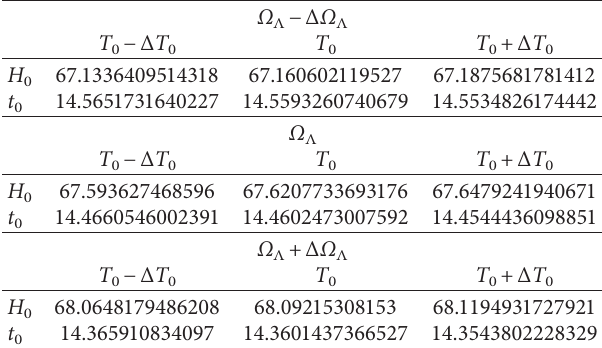
Table 3: H 0 (km/s/Mpc) and t 0 (Gyr).